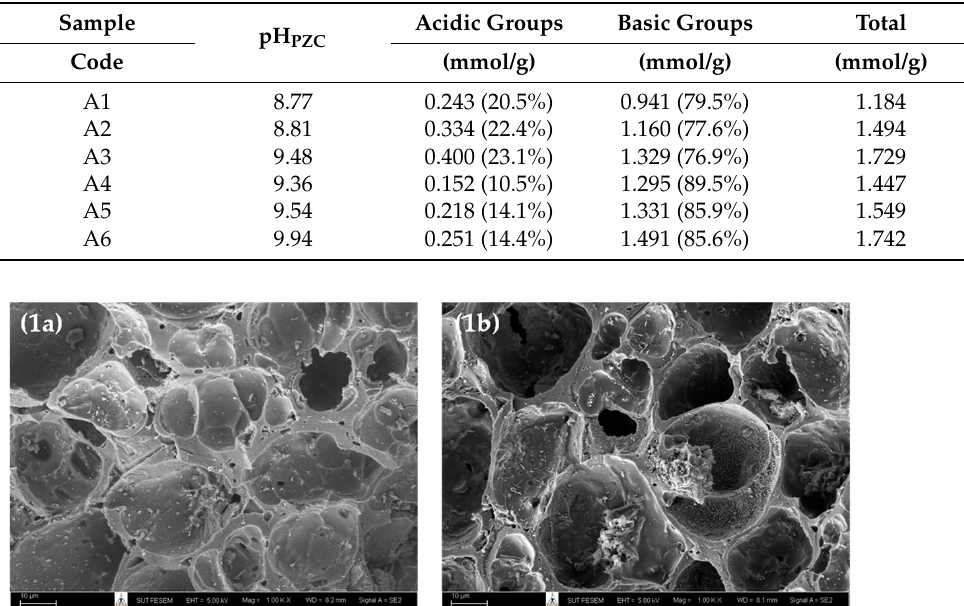
Table 4. Point of zero charge and surface functional groups in activated carbons.